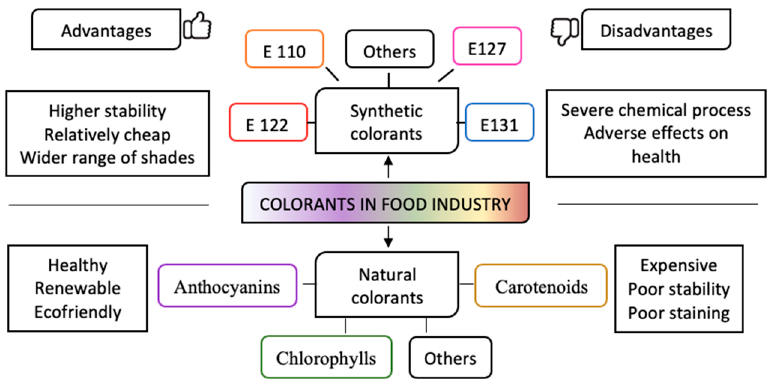
Figure 1. Natural and synthetic colorants’ advantages and disadvantages .